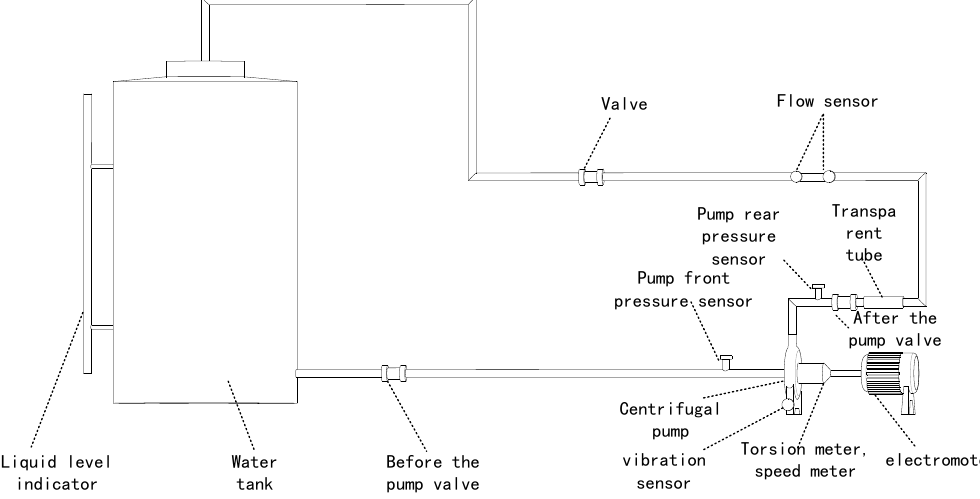
Figure 2. Laboratory centrifugal circulating water pump device.